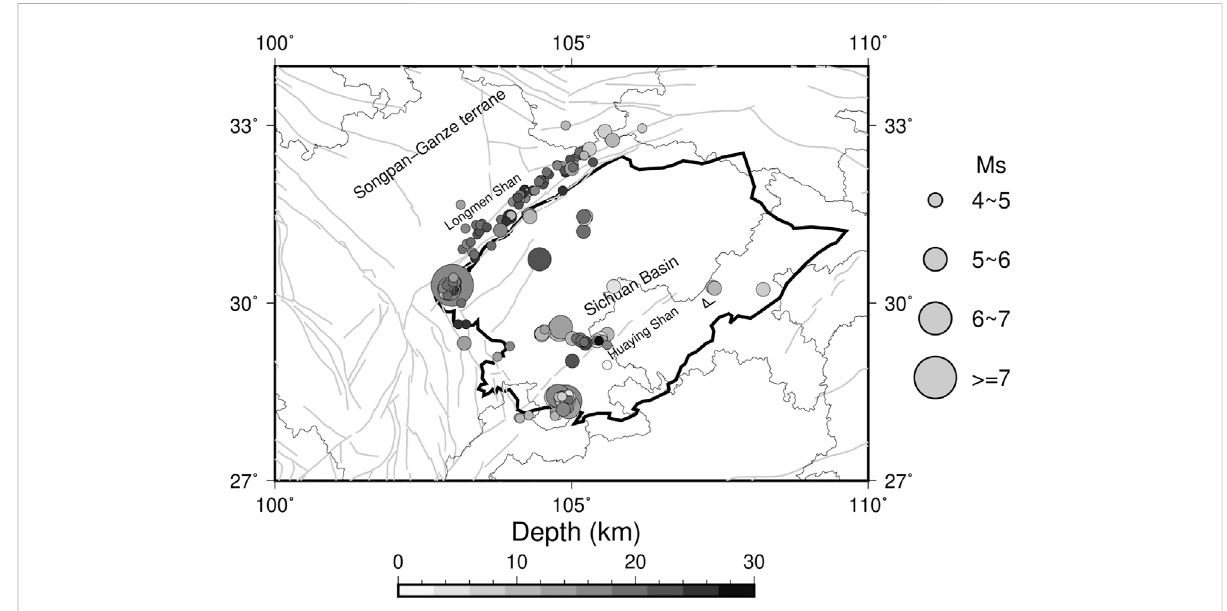
FIGURE 2 Map showing locations of the 189 earthquakes used in this study along with the earthquake source depths. Major faults in the study region are indicated by the gray lines. Magnitudes (Ms) of the earthquakes are used to scale the sizes of the